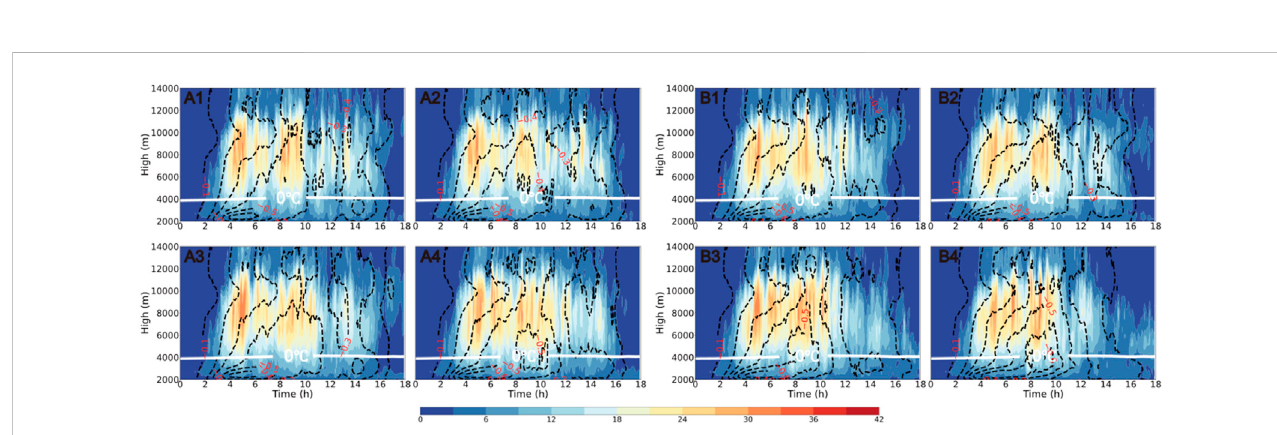
Time variation of height distribution ofmaximum updraft (Unit: m s − 1 )with the contour ofheight distributionof hourly mean downdraft(Unit:m s − 1 ),and the solid white line is the height of 0 ° C: (A) TH-AU. (B) MY-AU; (1) NCCN50 (2) NCCN200 (3) NCCN 2000 (4)